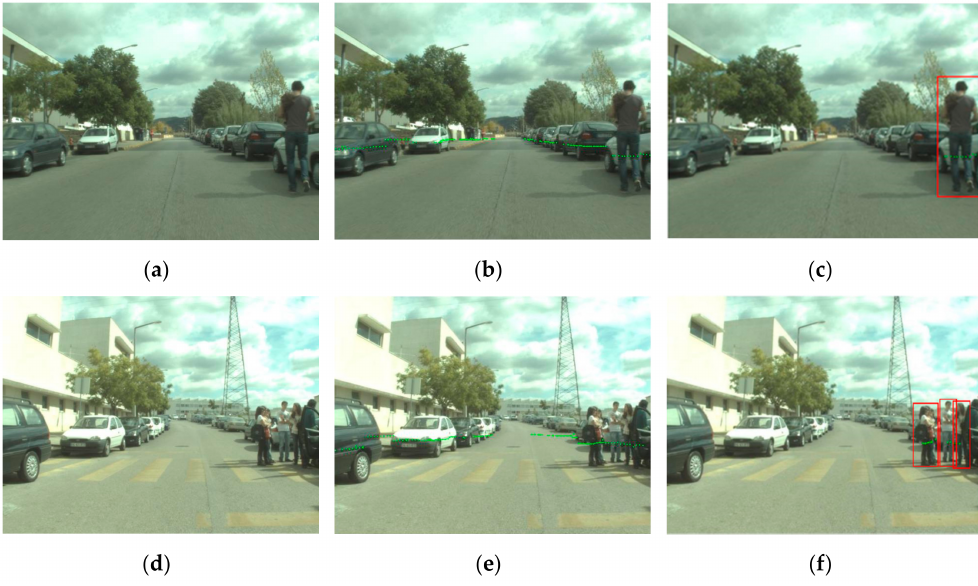
Figure 23. Sample of the LIPD images: ( a , d ) original frame, ( b , e ) calibrated image with laser scanner data (green points), and ( c , f ) detected human and corresponding laser data points in a